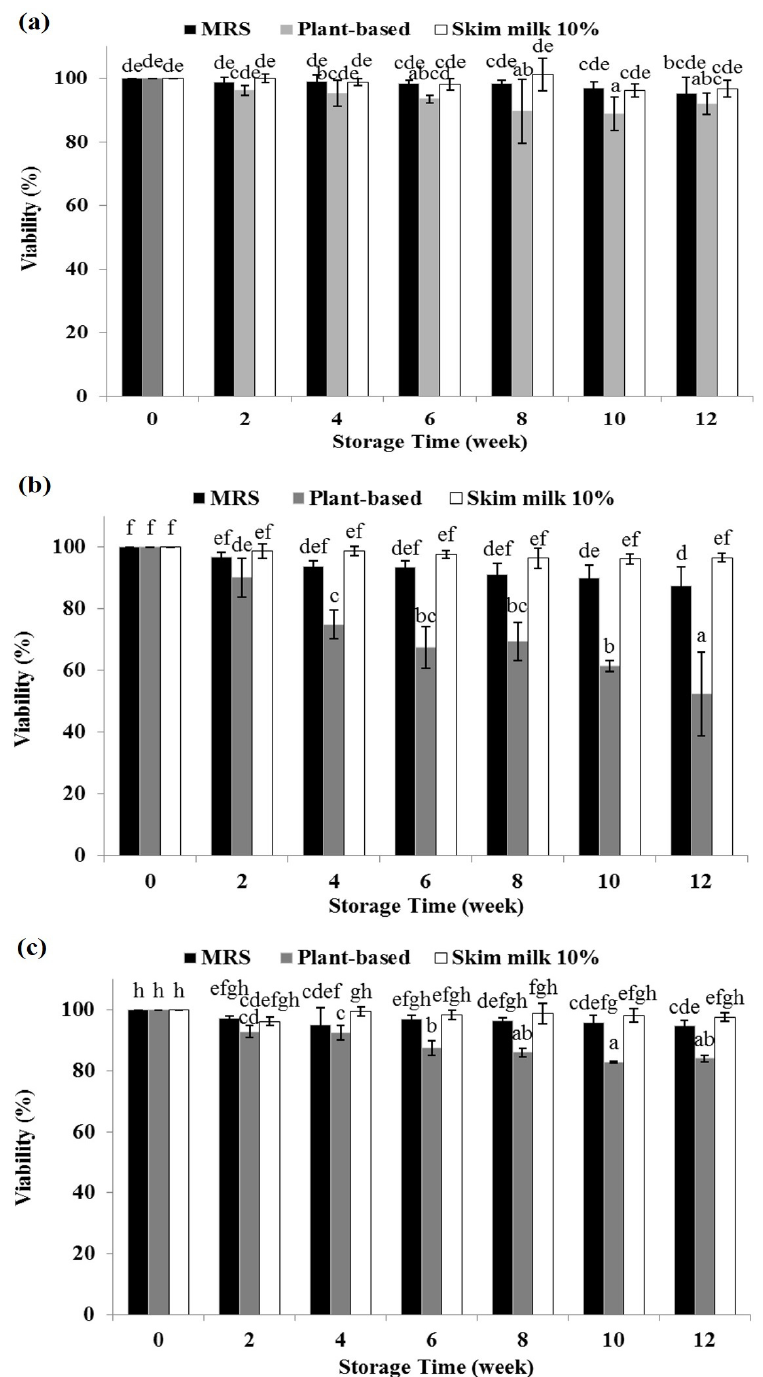
Figure 2. Viability of Lpb. plantarum TISTR 2075 ( a ); Lpb. plantarum MW3 ( b ); Lcb. casei TISTR 1463 ( c ) after frozen storage for three months in different media (frozen stock culture). Each color is the average of three replicates. Different superscripts indicate significant difference ( p < 0.05).